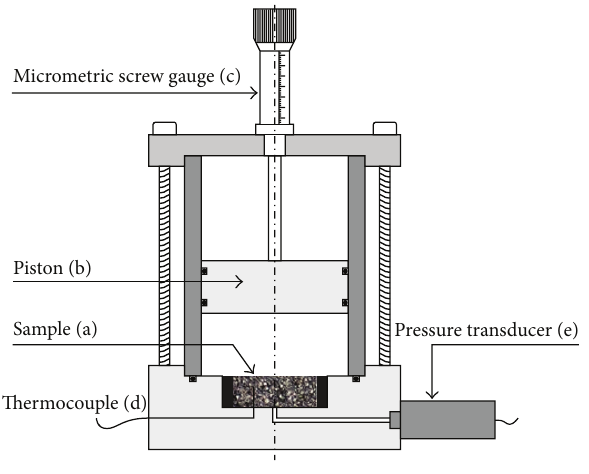
Figure 1: Schema of the activity meter. Table 1: Main dimensions of the experimental device (Figure 1). Sample